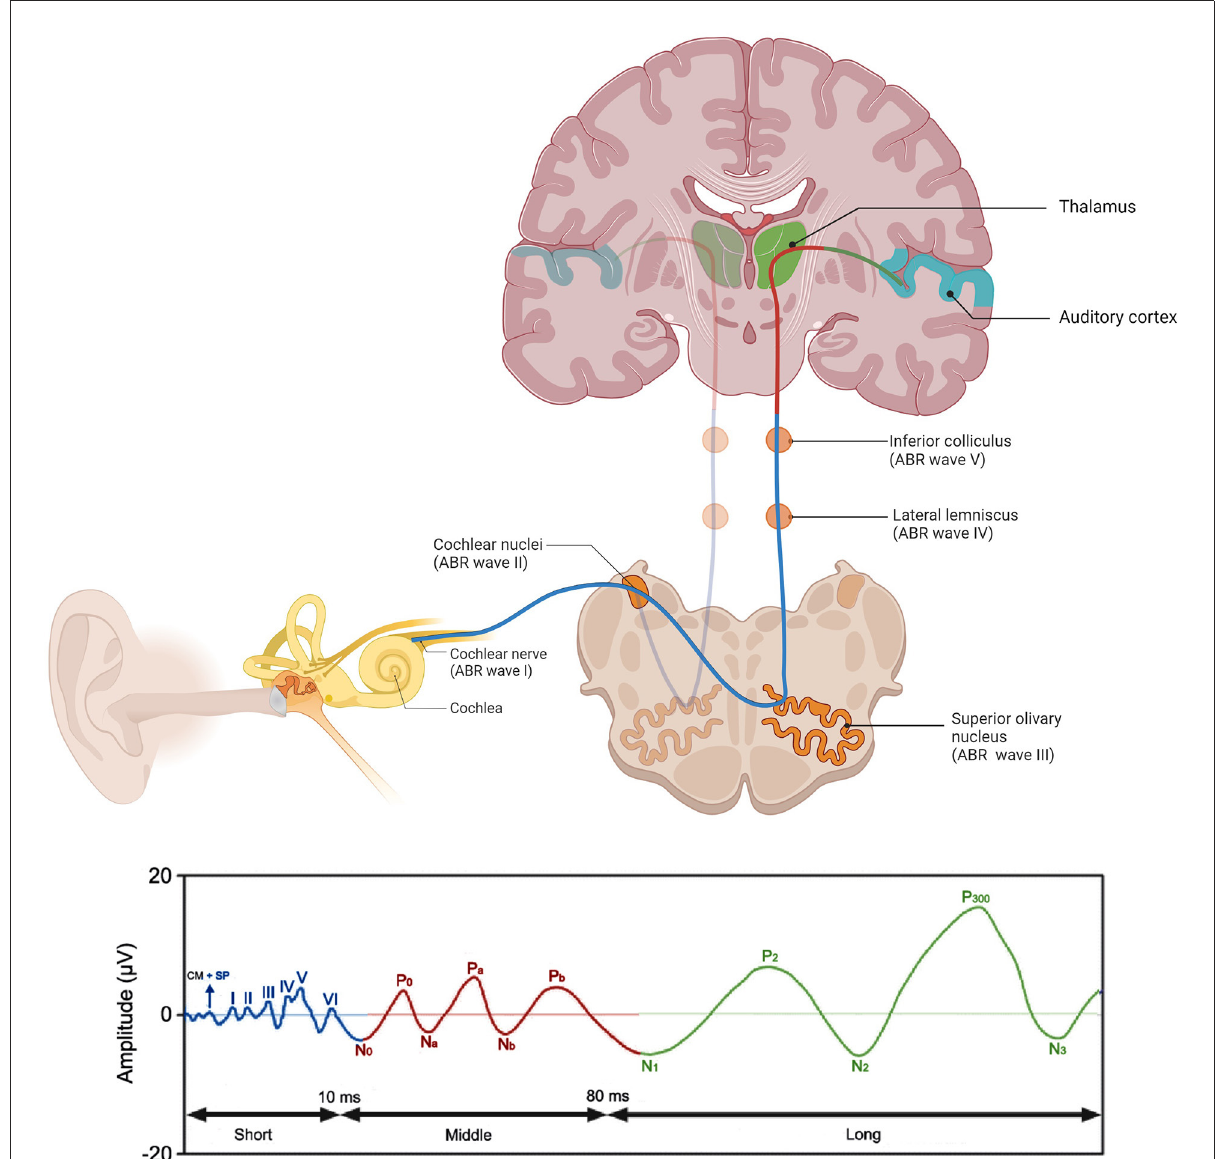
FIGURE1 Schematic representation of the auditory pathway and corresponding AEP components through stimulation with a click. These components include the auditory short-latency responses or auditory brainstem responses (ABR) (waves I-VI) (blue), the auditory middle latency responses (N0-Pb) (red), and the auditory late-latency responses (N1-P3) (green). Localization of the neuronal generators of the ABR waves are also depicted. Created with BioRender.com, AEPs adapted from Burkard et al. (21), Lammers